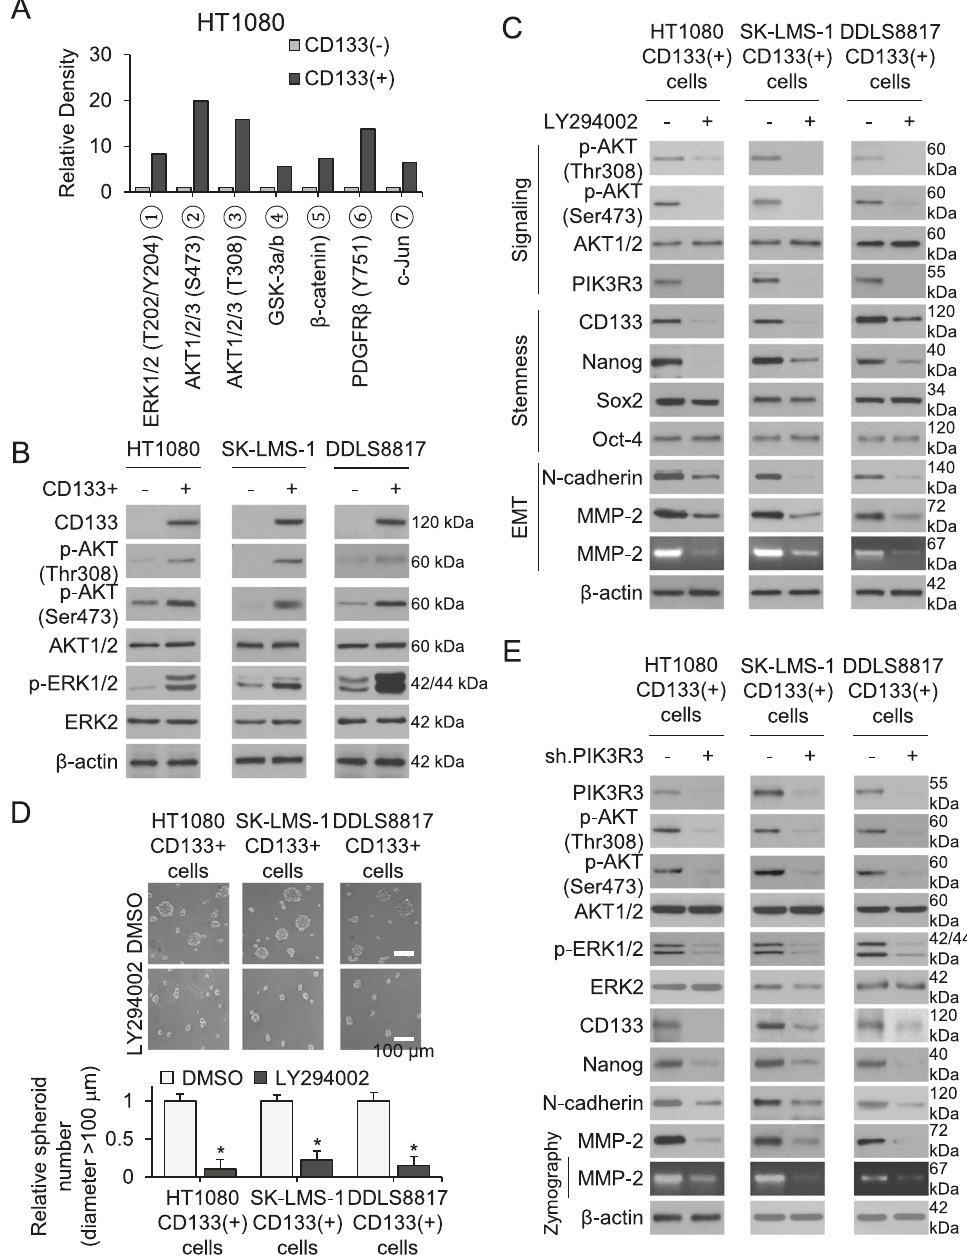
Fig. 4 PI3K activates the AKT/ERK signaling pathway in sarcoma CSCs. A – B Compare CD133 + vs. CD133 – cells. A Quantitation of phosphorylation of indicated kinases in HT1080 cells as measured by human phospho-kinase array. B Western blot for CD133, total and phosphorylated AKT1/2, and total and phosphorylated ERK1/2. C – D Compare LY294002 (10 μ M) vs. vehicle (DMSO)-treated CD133 + cells for 3 days. C Western blot and zymography for total and phosphorylated AKT1/2 and CD133, PIK3R3, Nanog, Sox2, Oct-4, N-cadherin, and MMP-2. D Spheroid formation. E Western blot and zymography for PIK3R3, total and phosphorylated ERK1/2, CD133, Nanog, N-cadherin, MMP-2, and MMP-2 in CD133 + spheroid cell lines transduced with sh.PIK3R3 or sh.Scr. β -actin is the loading control. * p < 0.05 compared to